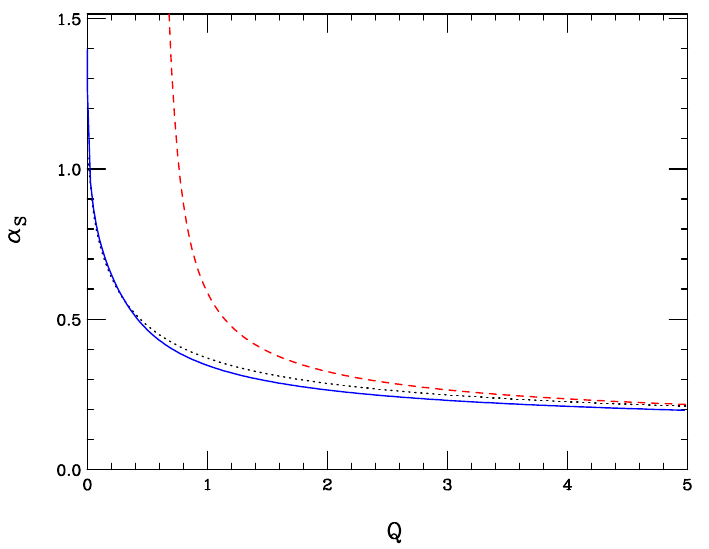
Figure 1. Standard (dashes line), analytic (dots), and effective (solid line) strong coupling constant at NNLO, as a function of the scale Q .